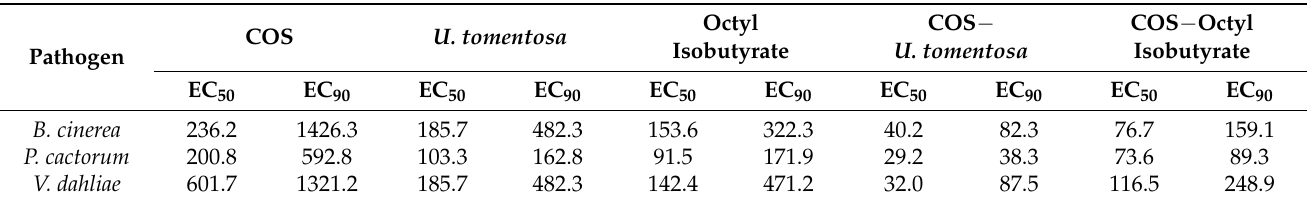
Table 2. Effective concentrations (expressed in µ g · mL − 1 ) against B. cinerea , P. cactorum , and V. dahliae of chitosan oligomers (COS), the ammoniacal extract of U. tomentosa bark, and octyl isobutyrate, alone and after conjugation.